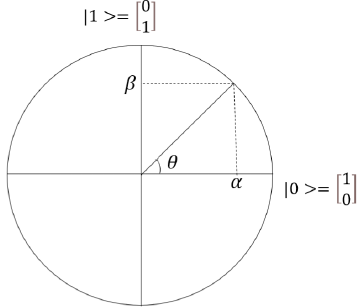
Figure 7. Polar plot for representation of